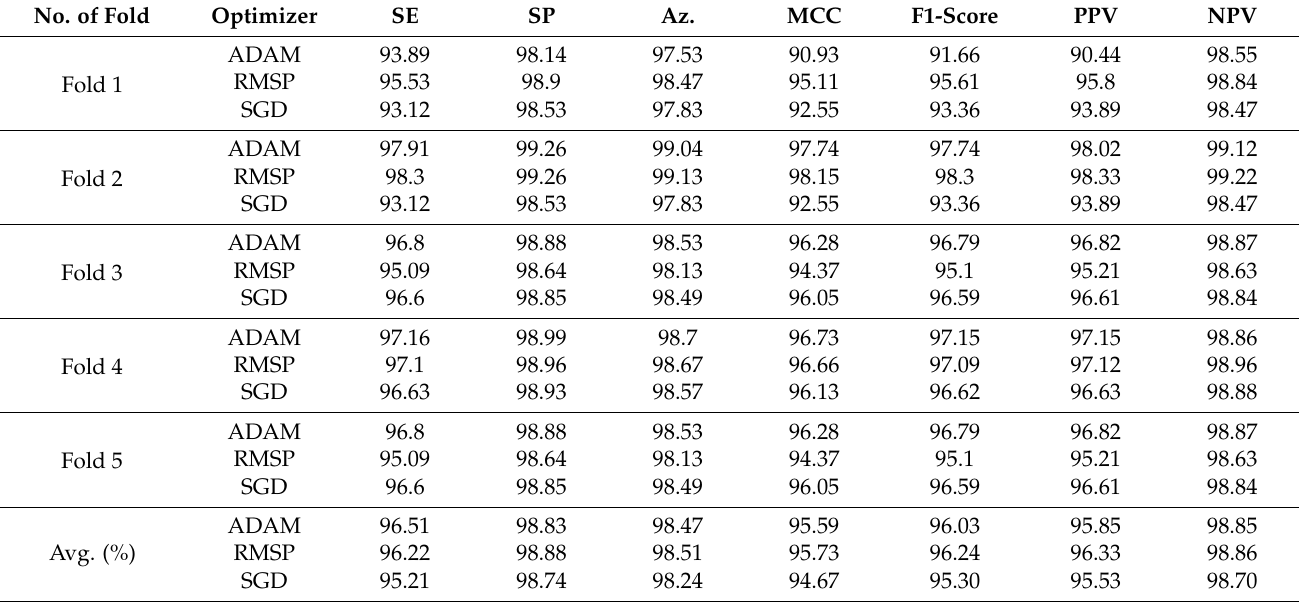
Table 2. Evaluation classification results (%) of the proposed BCNet with different optimizers for blood cell classification over 5-fold